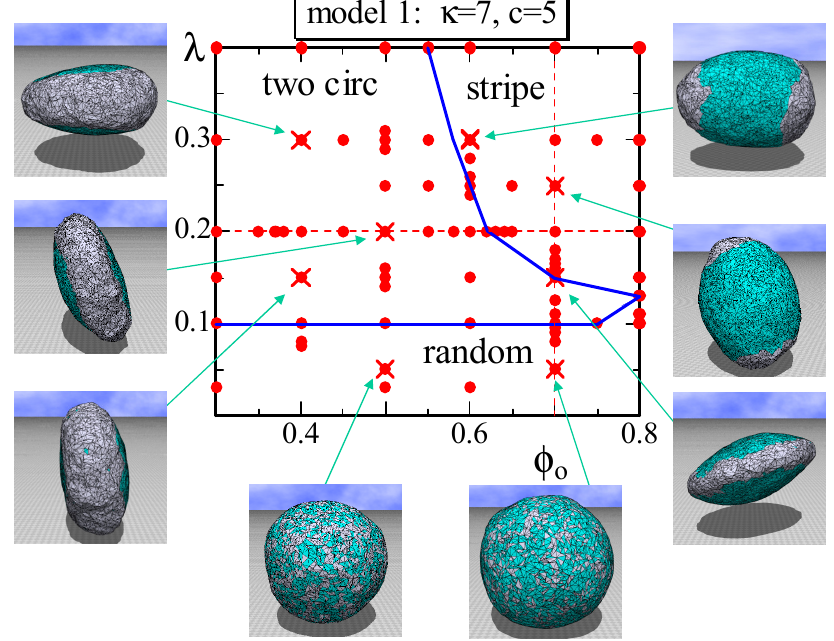
Figure 3. A phase diagram of Model 1 on the λ − φ o plane at κ = 7 and c = 5 and the snapshots of surfaces obtained at the points indicated by the symbol ( × ). The solid lines denote the phase boundaries, and the dashed lines denote the positions for the simulations for Figure 4a–c. The solid circles ( • ) denote the data points of the simulations for the phase boundaries. The two circular domains and the stripe domain correspond to the L o phase, which is DPPC rich. The two separated domains on the surface of the striped domain and the connected domain on the surface of two circular domains correspond to the L d phase, which is DOPC rich.